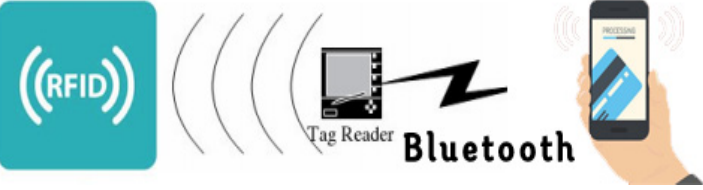
Figure 1. RFID System with Tags.